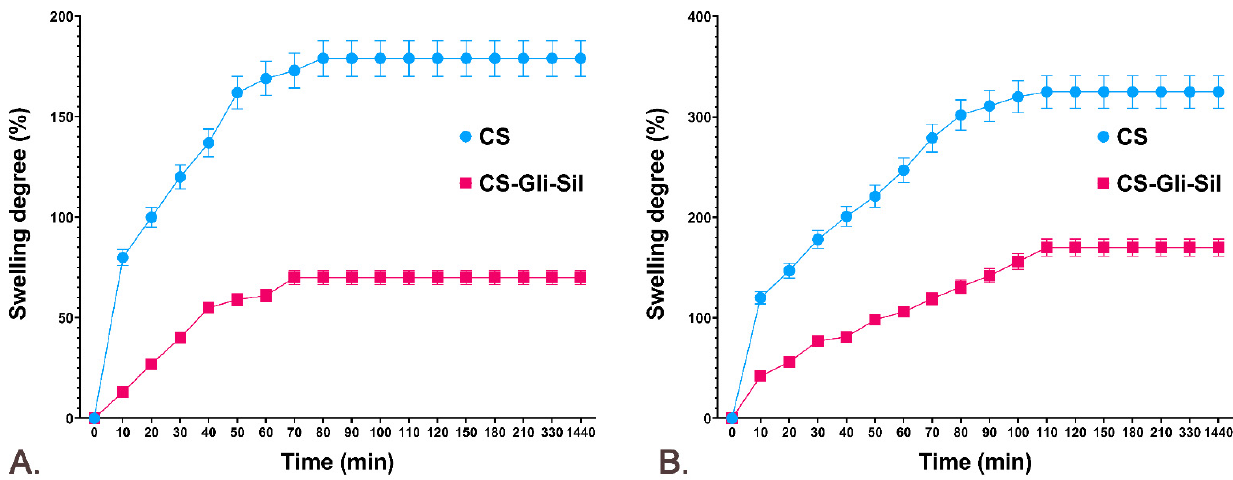
Figure 4. The CS and CS-Gli-Sil swelling degree (%): ( A ) in distilled water; ( B ) in simulated gastric fluid.